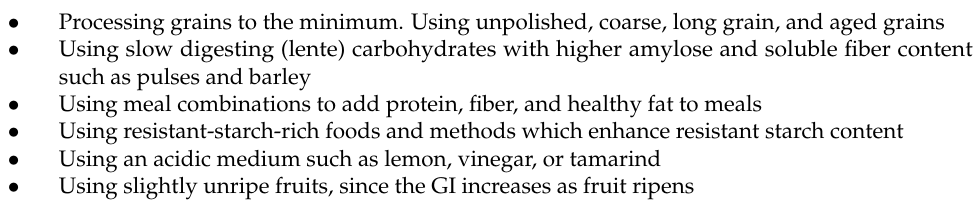
pulse combinations, Table S4: Some examples of commonly consumed beverages of India, Table S5: Some examples of festive foods of